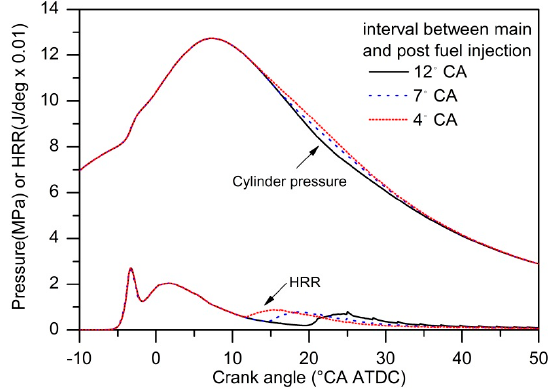
Figure 11. Comparisons of in-cylinder pressure and heat release rate versus crank angle under the cases of assigned EGR stratification with different interval crank angle between main and post injection.